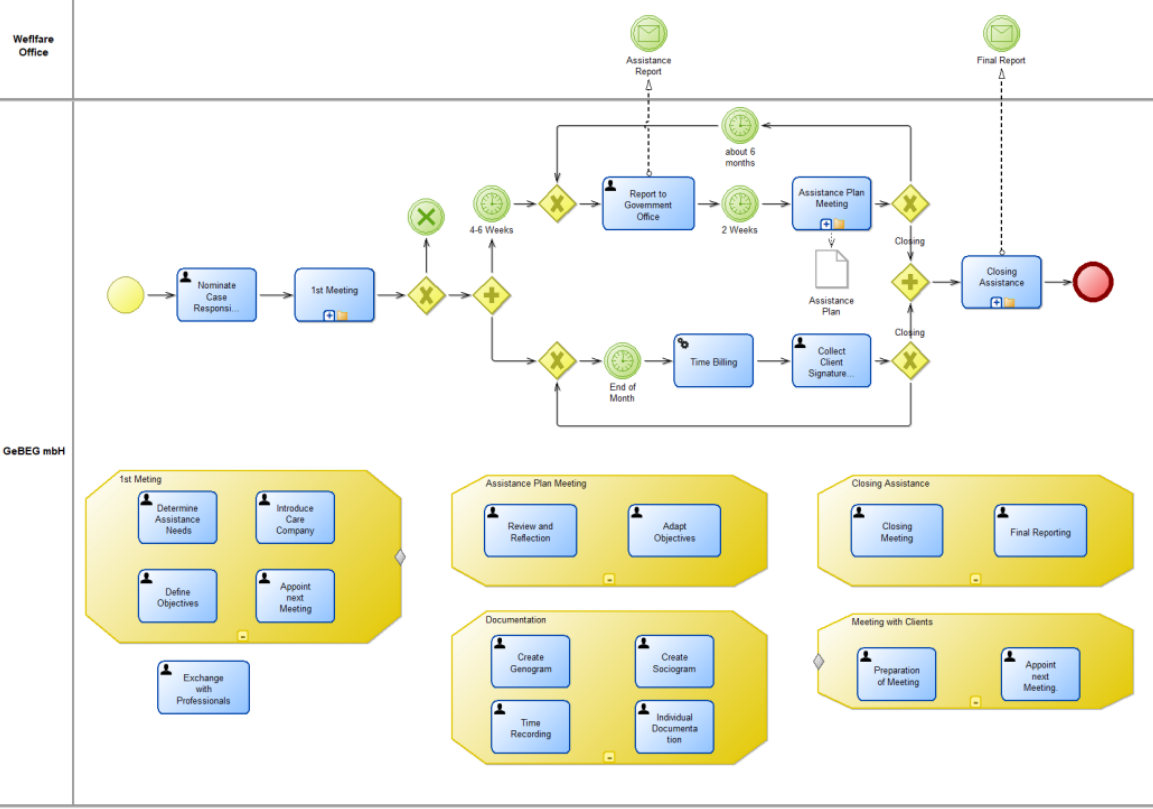
Figure 6. Process Template “Assistance for Child Upbringing” in